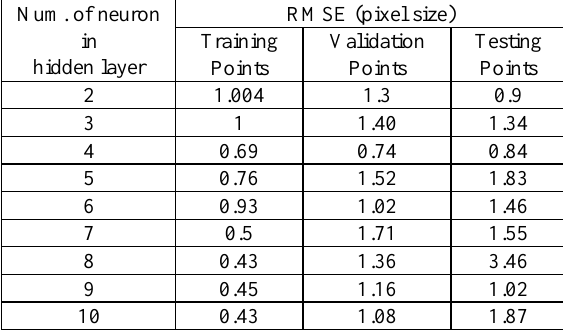
Table 2. Results of geometric modelling of satellite images with artificial neural network